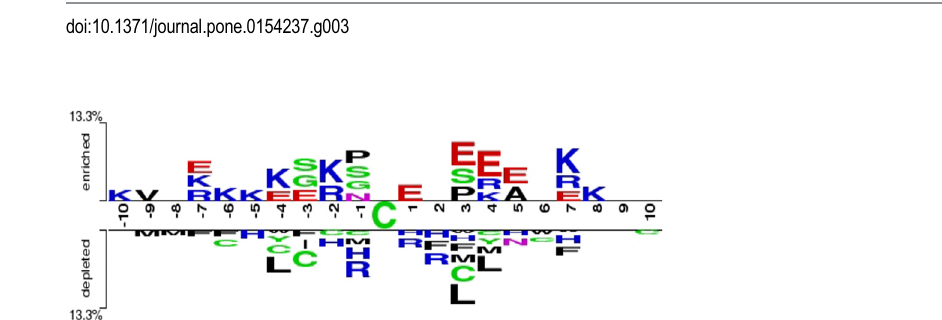
Fig 4. The TwoSampleLogo between sulfenylation and non-sulfenylation peptides (p < 0.01).